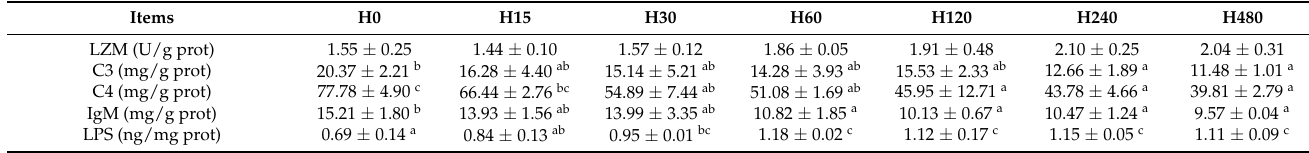
Table 6. Effect of dietary histamine on intestinal immunity of striped